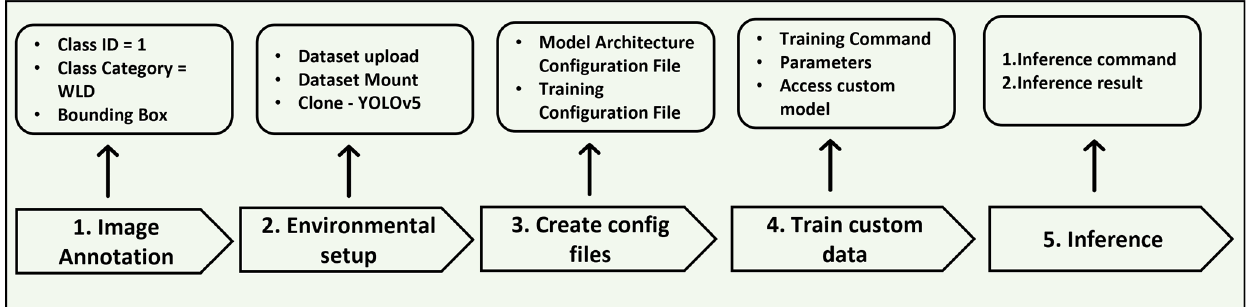
Figure 5. Main steps in the development of YOLOv5 model.